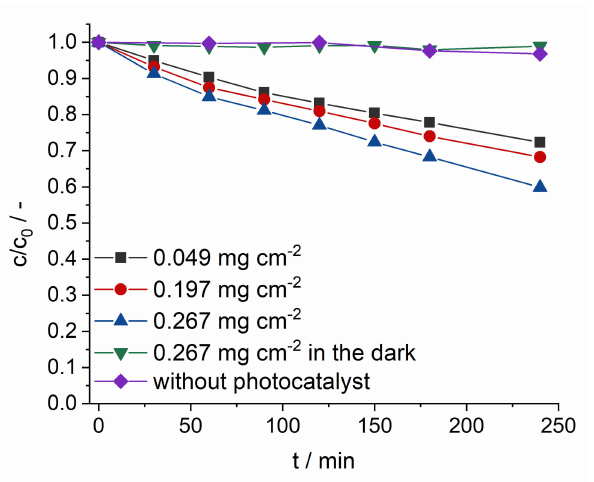
Figure 6. 4-chlorophenol concentration (measured by HPLC) decrease under light (without photocat- alyst and for 3 contents of g-C 3 N 4 ), and for 0.267 mg cm − 2 , in the dark. A one-week-aged suspension was used for layer deposition on FTO glass; the light source was a UV Sylvania Lynx-S BLB, with a broad maximum at 365 nm. The initial concentration of 4-CP was 10 − 4 mol dm − 3